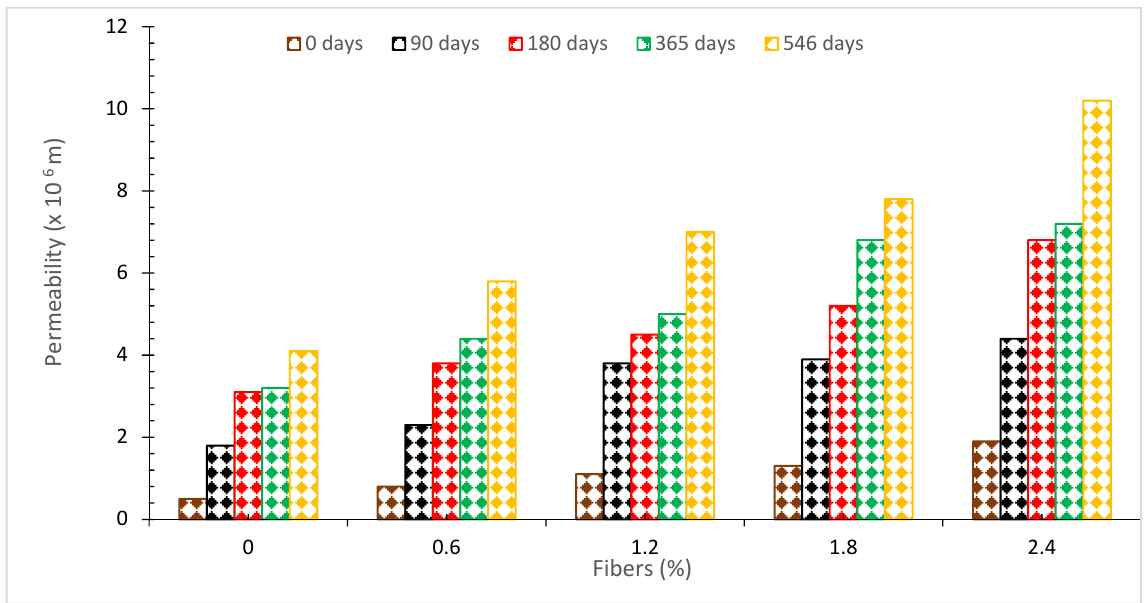
Figure 15. Permeability [37].